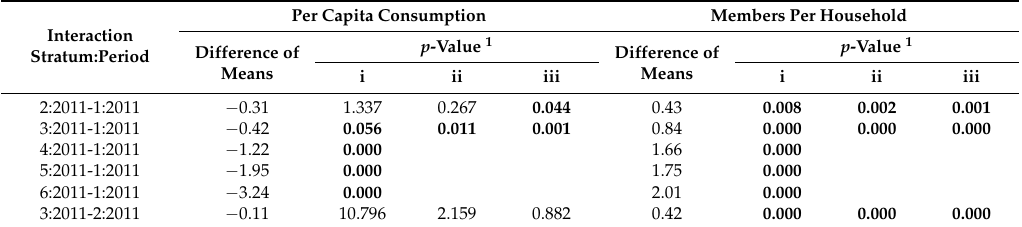
Table A4. Tukey’s Test. Variables: Per capita consumption and Members per